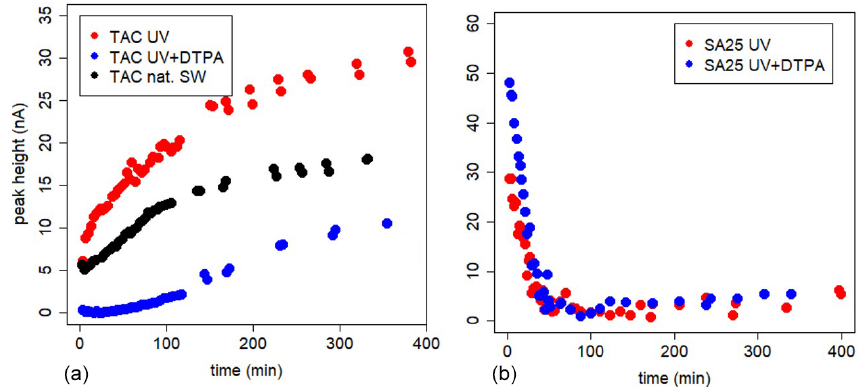
Figure 3. In-cell kinetic experiments, with the three AL applications, in UV-irradiated seawater, UV-irradiated seawater + DTPA (200nM for TAC and 40nM for the SA25 application) and natural seawater. For SA25 UV and UV + 40nM DTPA was done. At t = 0 AL is added.